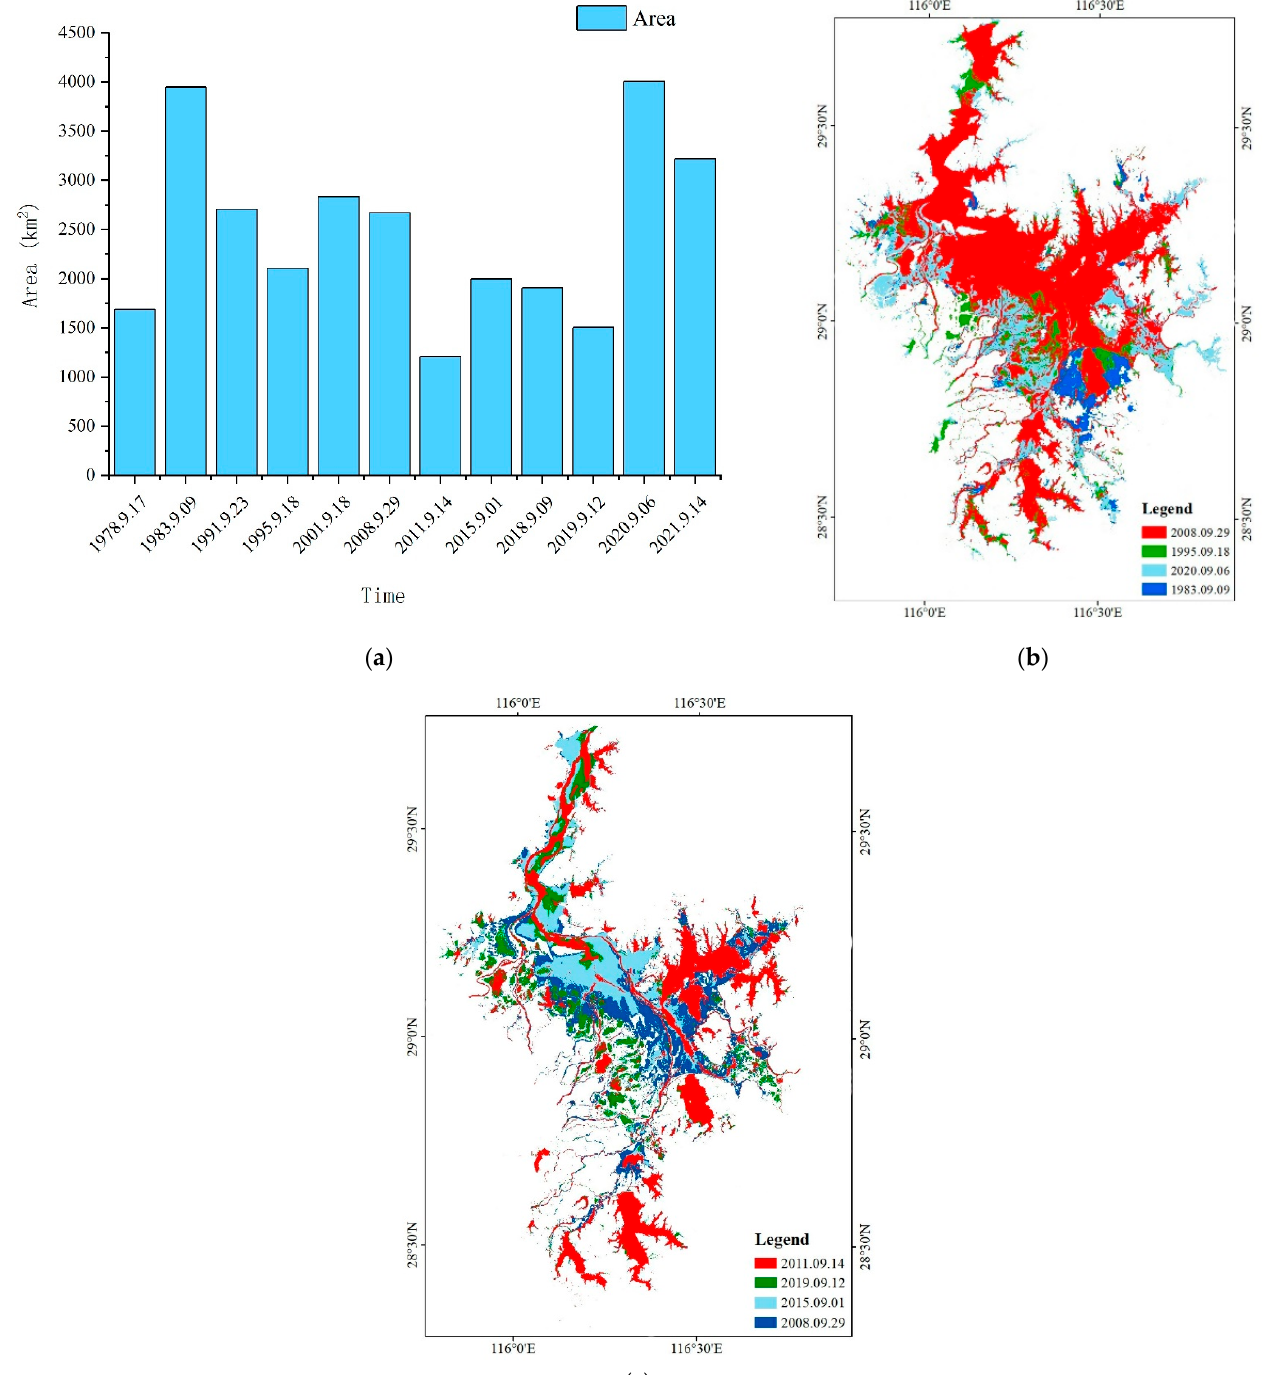
Figure 12. Comparison of lake water area at the end of flood season: ( a ) description of lake water area at the end of the flood season; ( b ) comparison of lake water area extraction results at the end of flood season. ( c ) Comparison of lake water area extraction results at the end of flood season.